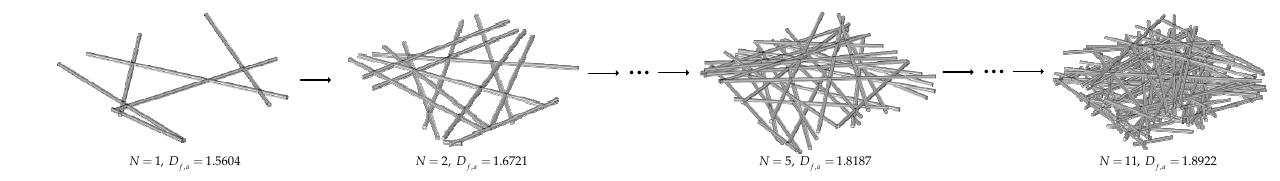
Figure A2. The example of 3D fiber reconstruction.